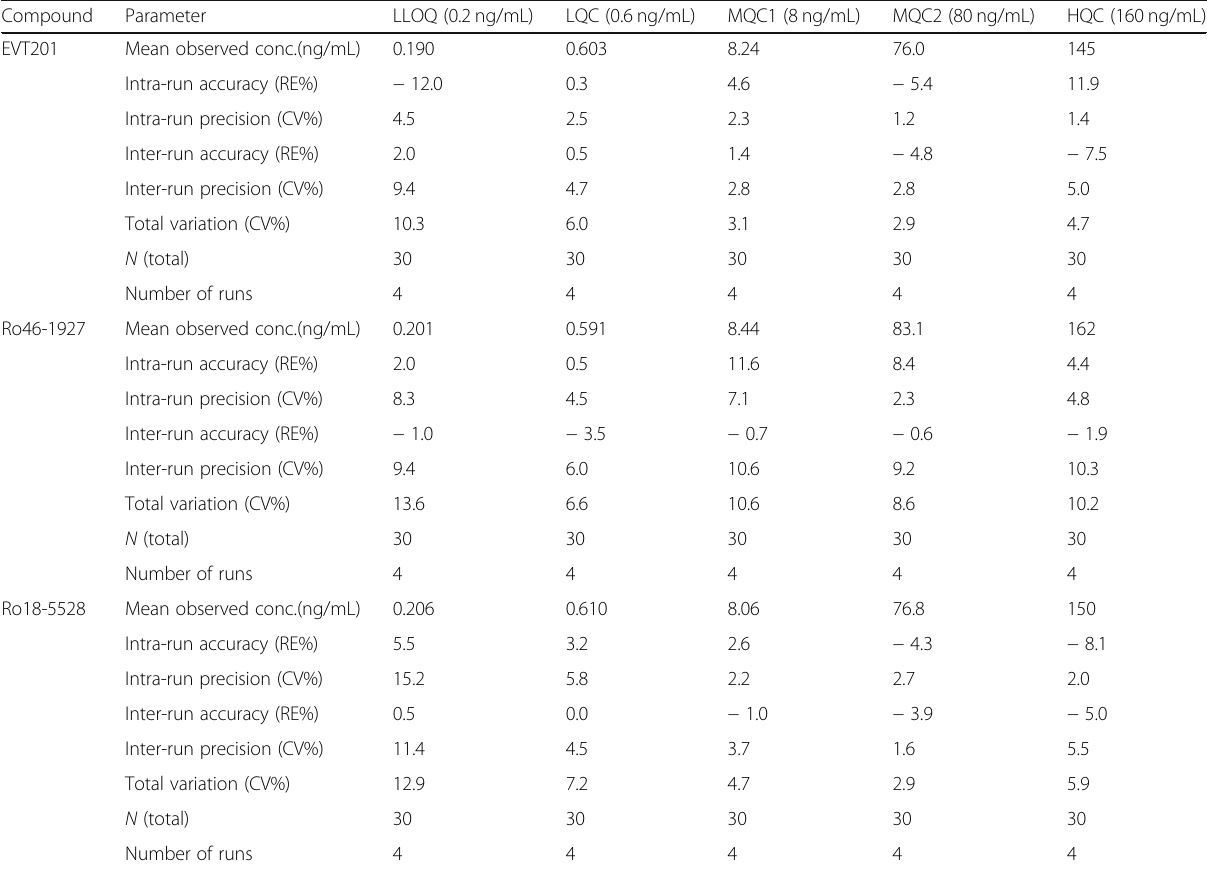
Table 1 Precision and accuracy of EVT201 and its two metabolites in human urine Compound Parameter